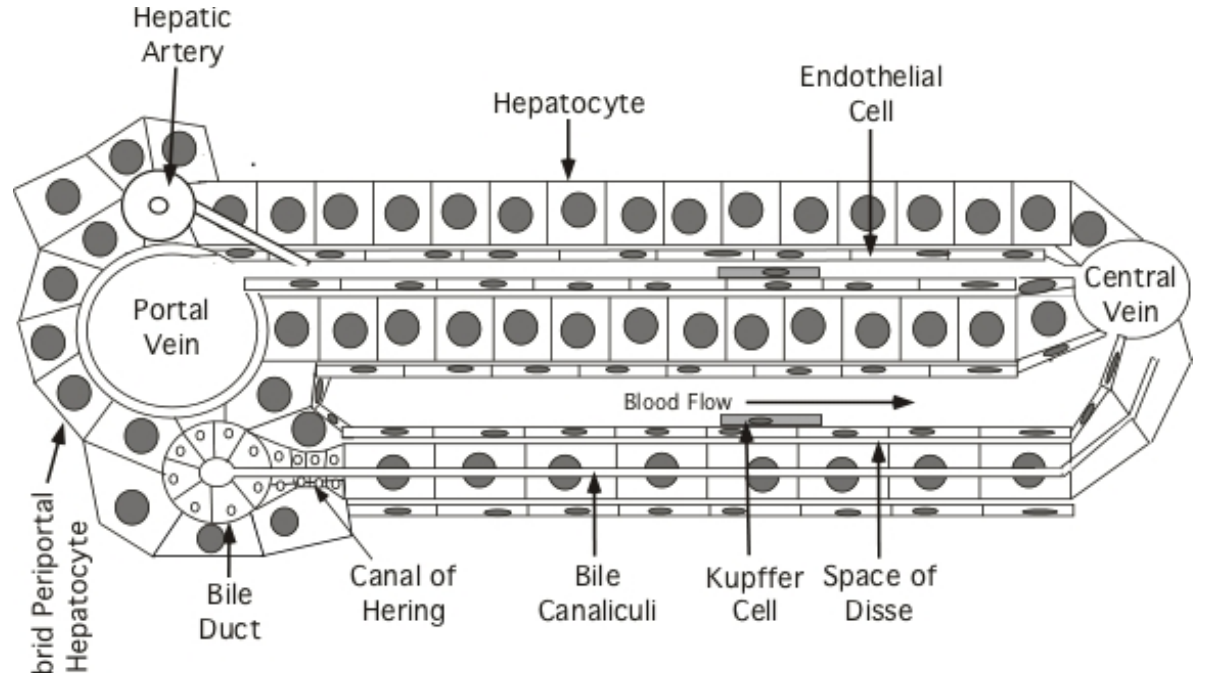
Figure 2. Structure of the hepatic lobule: schematic, essentially one dimensional view, of the hepatic lobule, illustrating a few tracts of hepatocytes and supporting cells extending from a portal vein (in the portal triad) to a central vein. Hepatocytes or a subset of the hepatocytes constituting the limiting membrane around the portal triads (hybrid periportal hepatocytes), have the proliferative capacity to respond to severe liver injury and restore the hepatocyte population of the lobule [66]. Arterial and venous blood enters the sinusoids of the lobule at a portal triad and is collected at a central vein. Bile is secreted from hepatocytes into bile canaliculi, formed at the junction of adjacent hepatocytes, and flows into the bile ducts. The sinusoids are lined with a fenestrated endothelium; whether the fenestrations are large enough to allow free passage of HBV from the blood to hepatocytes is controversial, with an alternate suggestion that virus is actively transported from the blood stream to hepatocytes [71]. Kupffer cells (liver macrophages) are also shown, as well as the cells that form the Canals of Hering, which facilitate transport of bile from canaliculi to the bile ducts and have also been proposed to be hepatocyte progenitor cells [67]. Hepatic stellate cells (not shown), found within the Space of Disse, are multifunctional and, in the context of chronic HBV infection, are responsible for the development of cirrhosis in response to chronic liver injury. Figure adapted from Jilbert et al., 2008. Pathogenesis of HBV Infections, Chapter 7: HBV Human Virus Guide, 2nd Ed, CL Lai and S Locarnini Eds. Reproduced with permission from International Medical Press.